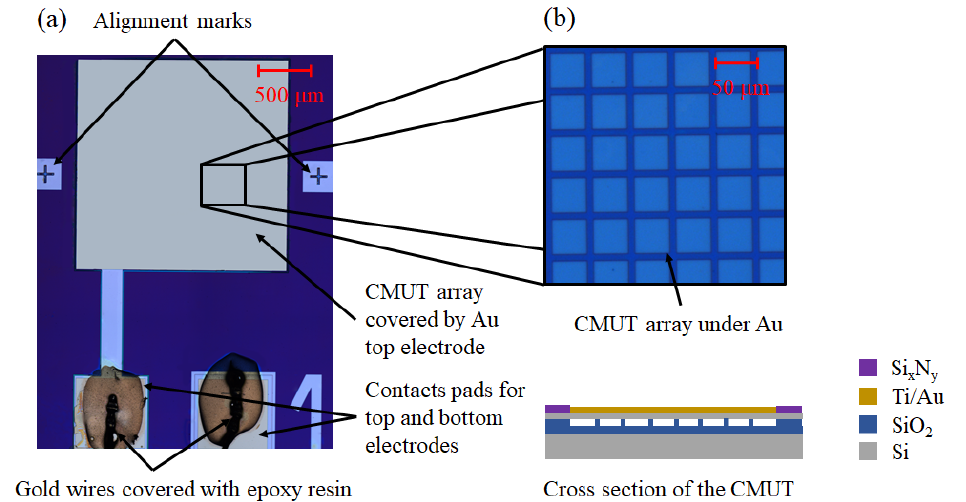
Figure 2. ( a ) Micrograph of the CMUT device showing the array, contact pads for top and bottom electrodes, and the alignment marks used in photolithography steps and for inkjet printing alignment; ( b ) micrograph of the CMUT array under the top electrode and its cross section